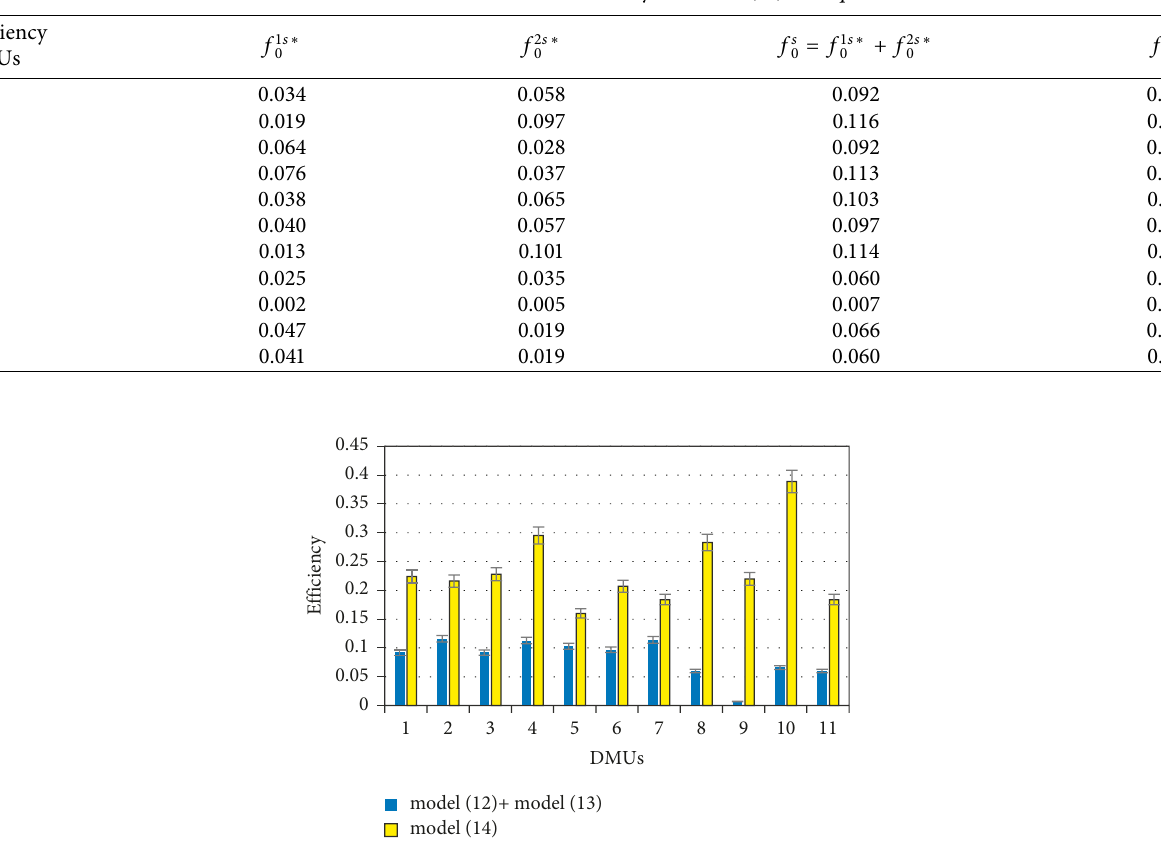
Table 10: The results of the overall efficiency of model (14) with p � 0 .